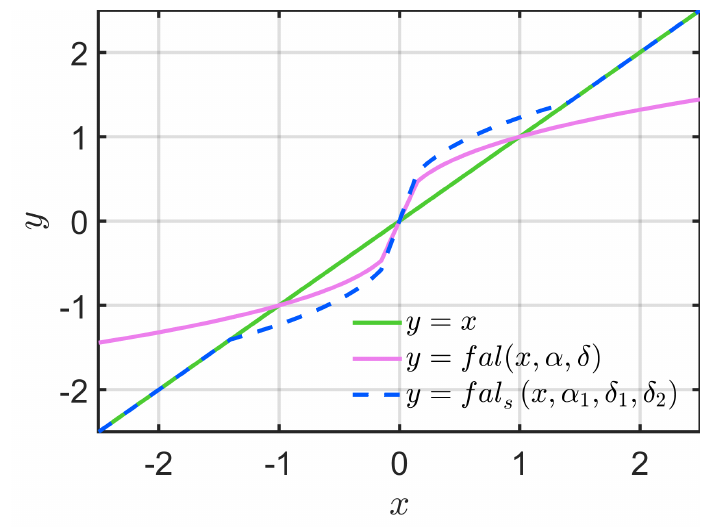
Figure 3. Comparison of the linear function, f al ( x , α , δ ) and f al s ( x , α 1 , δ 1 , δ 2 ) .